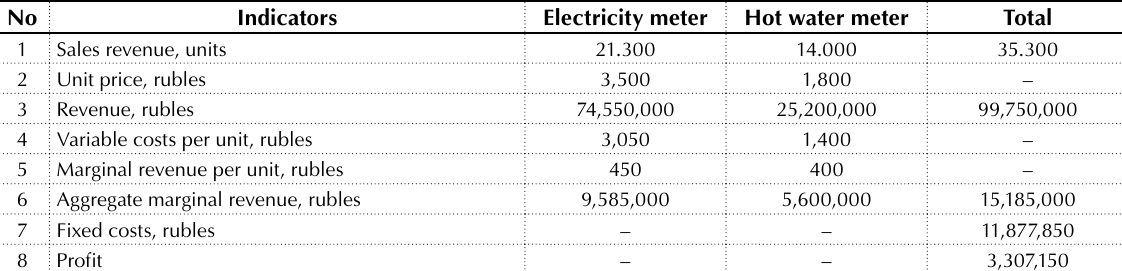
Table 6. Information characterizing the activities of the enterprise at the current production output and prices for products called electricity meter and hot water meter at the same